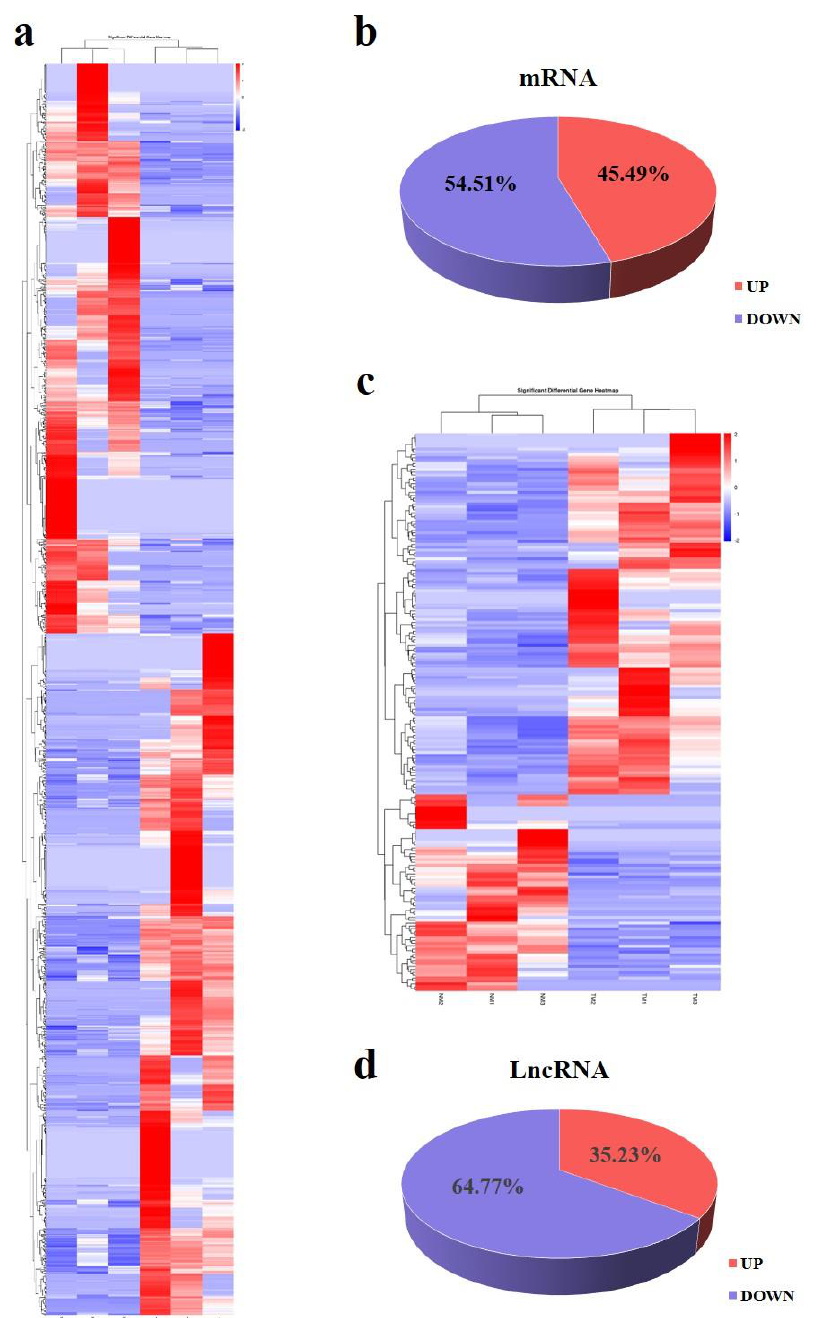
Figure 4. The differential expressed (DE) lncRNAs and mRNAs analysis: ( a ) and ( c ) represent the volcano plot of DE mRNAs and lncRNAs, respectively; ( b ) and ( d ) represent the up- and down-regulated ratio of DE mRNAs and lncRNAs, respectively. The red to blue color represents the fold change value from high to low.